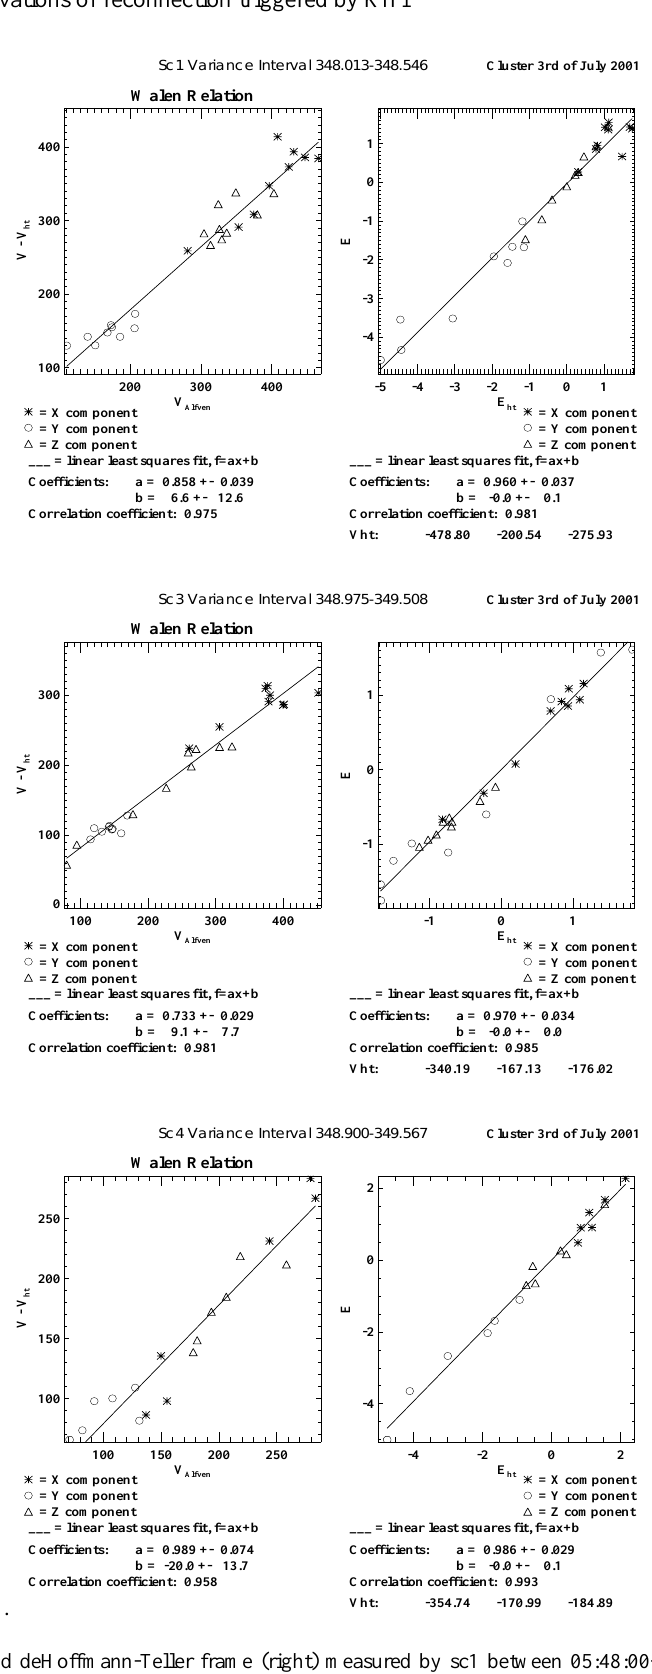
Fig. 9. Wal´en relation (left) and deHoffmann-Teller frame (right) measured by sc1 between 05:48:00–05:48:33 UT (top) sc3 between 05:48:58–05:49:31 UT (middle) and sc4 between 05:48:54–05:49:34 UT